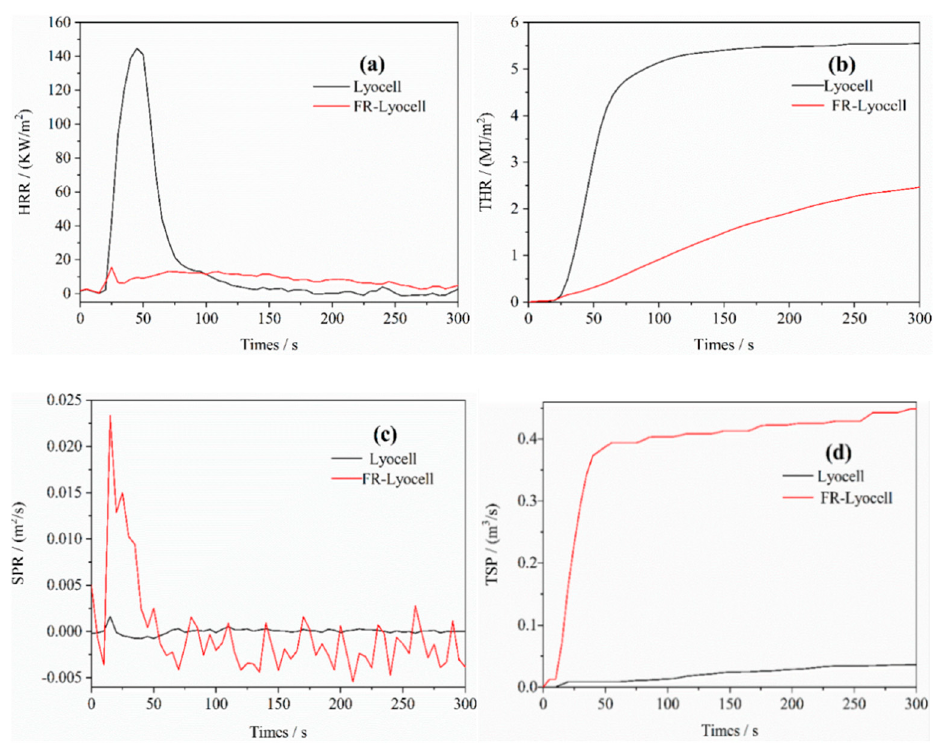
Figure 9. HRR ( a ), THR ( b ), SPR ( c ), and TSP ( d ) curves of lyocell and FR − lyocell fabrics.